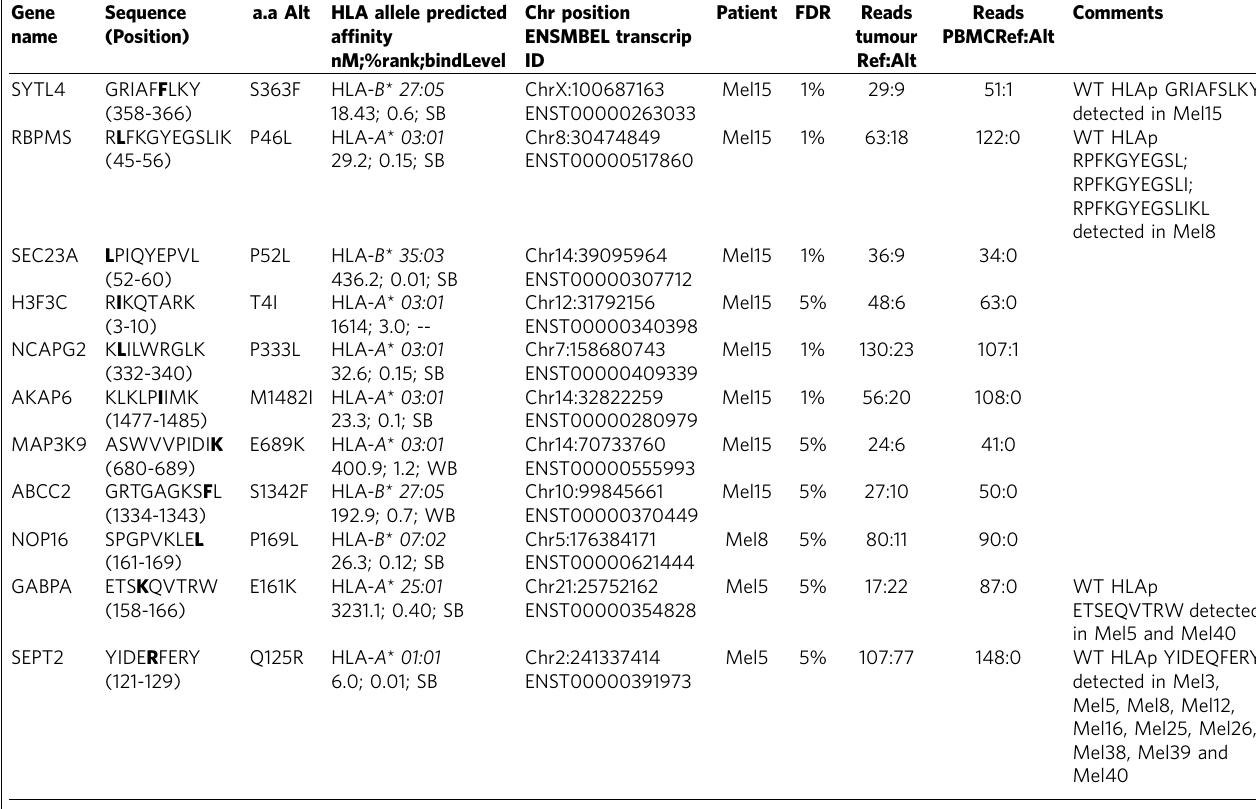
Mutated amino acids within the peptides are indicated with bold